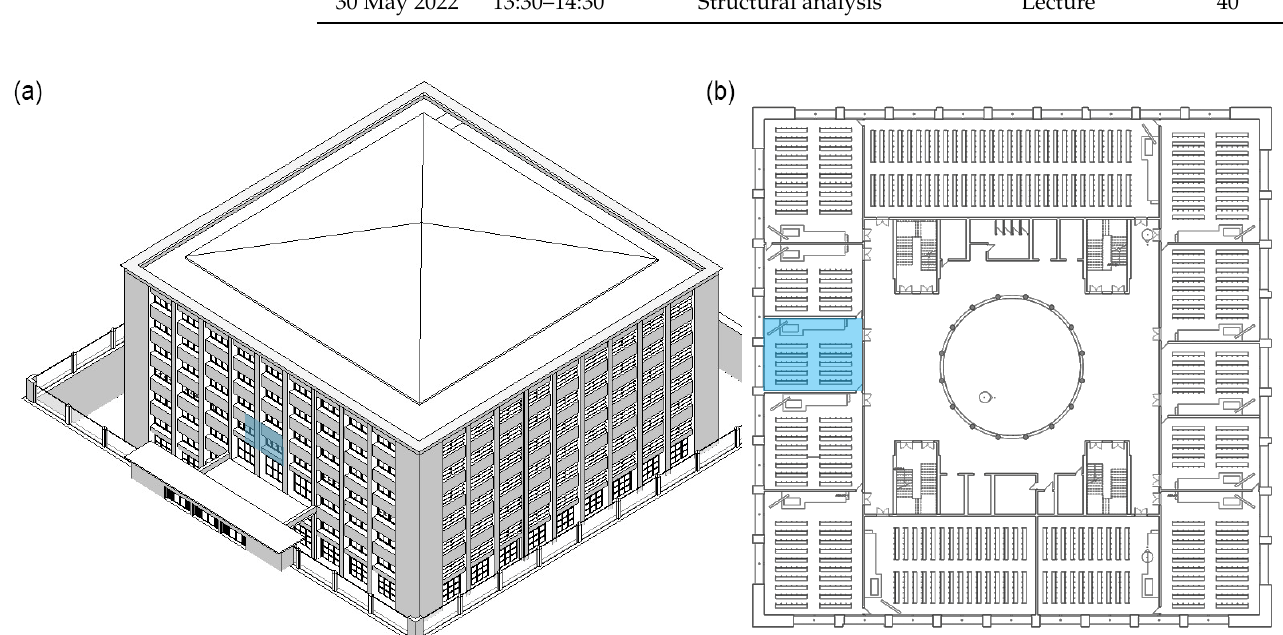
Figure 7. ( a ) BIM model of polytechnic building. ( b ) Plan of the first floor. Blue colour indicates classroom 110.